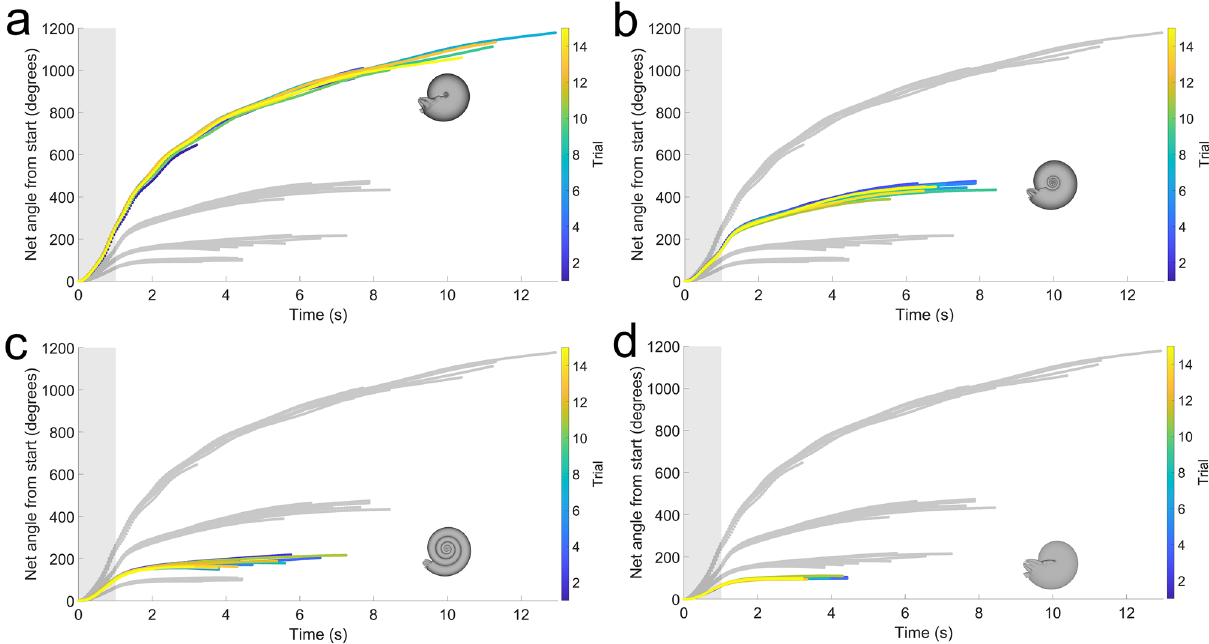
Figure 7. Maneuverability about the vertical axis (yaw). The net angle from starting position was recorded while monitoring rotation about the vertical axis. Each model experienced jet thrust oriented 90° to the lever arm passing between the hyponome and vertical axis passing through the hydrostatic centers. ( a ) Sphaerocone, ( b ) morphospace center, ( c ) serpenticone, and ( d ) oxycone. Shaded regions denote the time the motor was active (first second). Shaded curves denote the relative kinematics of each other robot. Colors indicate the trial performed for each robot (15 each).